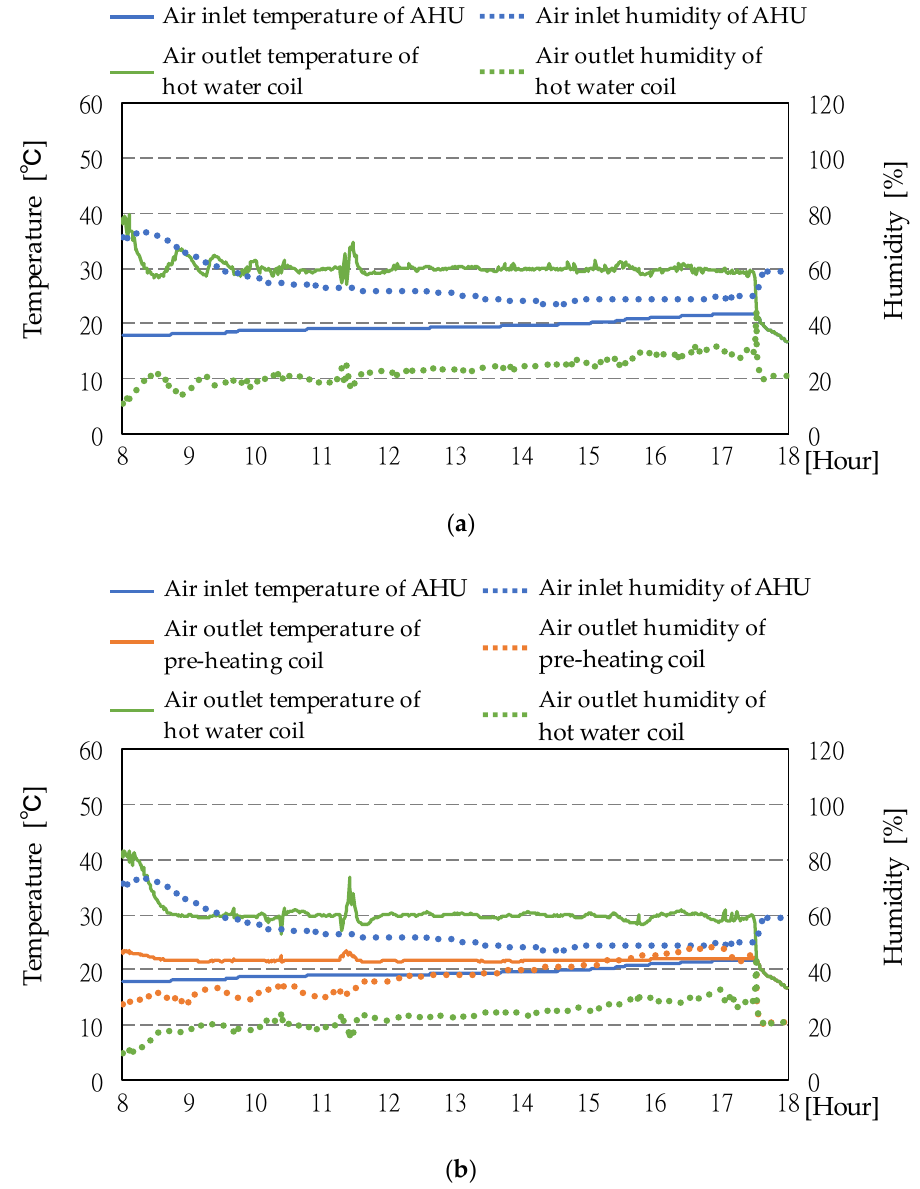
Figure 12. Air temperature and humidity before and after the AHU by the heating operation. ( a ) Hot water coil operation (Case ATES-C1). ( b ) Pre-heating coil operation (Case ATES-C2-2).